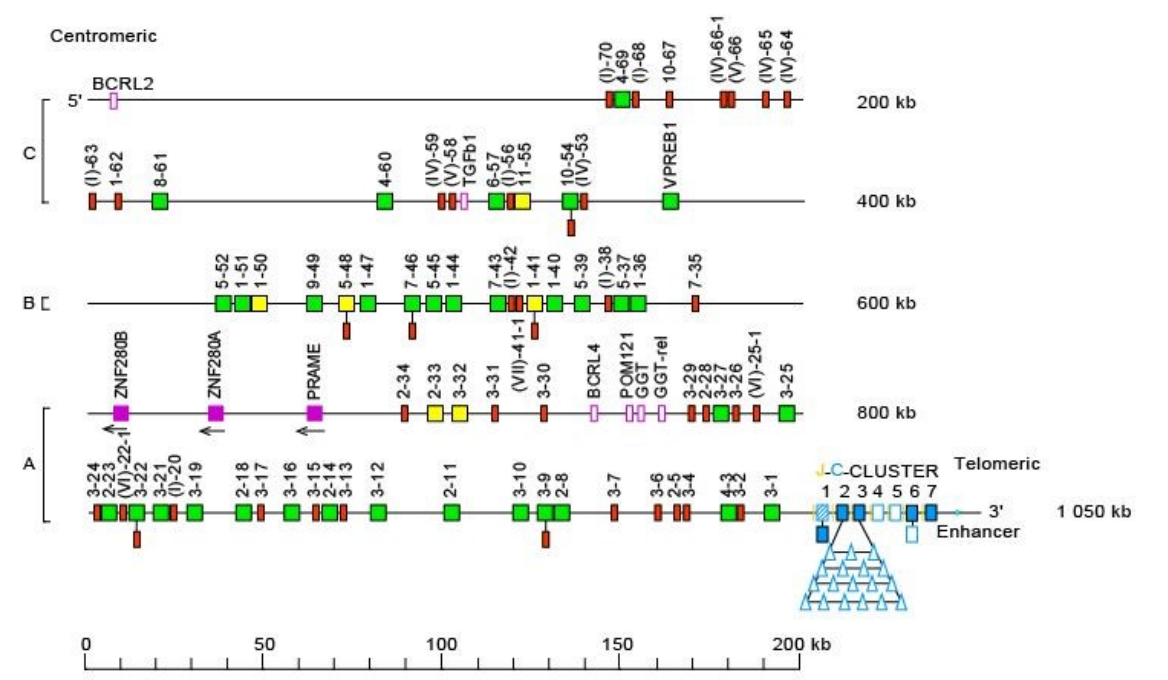
Figure 8. Representation of the human IGL locus at 22q11.2 (FWD orientation on the chromosome) [2,5]. The boxes representing the genes are not to scale. Exons are not shown. ( A – C ) refer to three distinct V ‐ CLUSTER based on the IGLV gene subgroup content [149]. Pseudogenes that could not be assigned to subgroups with functional genes are designated by a Roman numeral between parentheses, corresponding to the clans, followed by a hyphen, and a number for the localization from 3 ′ to 5 ′ in the locus. IMGT ® http://www.imgt.org (Accessed on 20 February 2022) , IMGT Repertoire